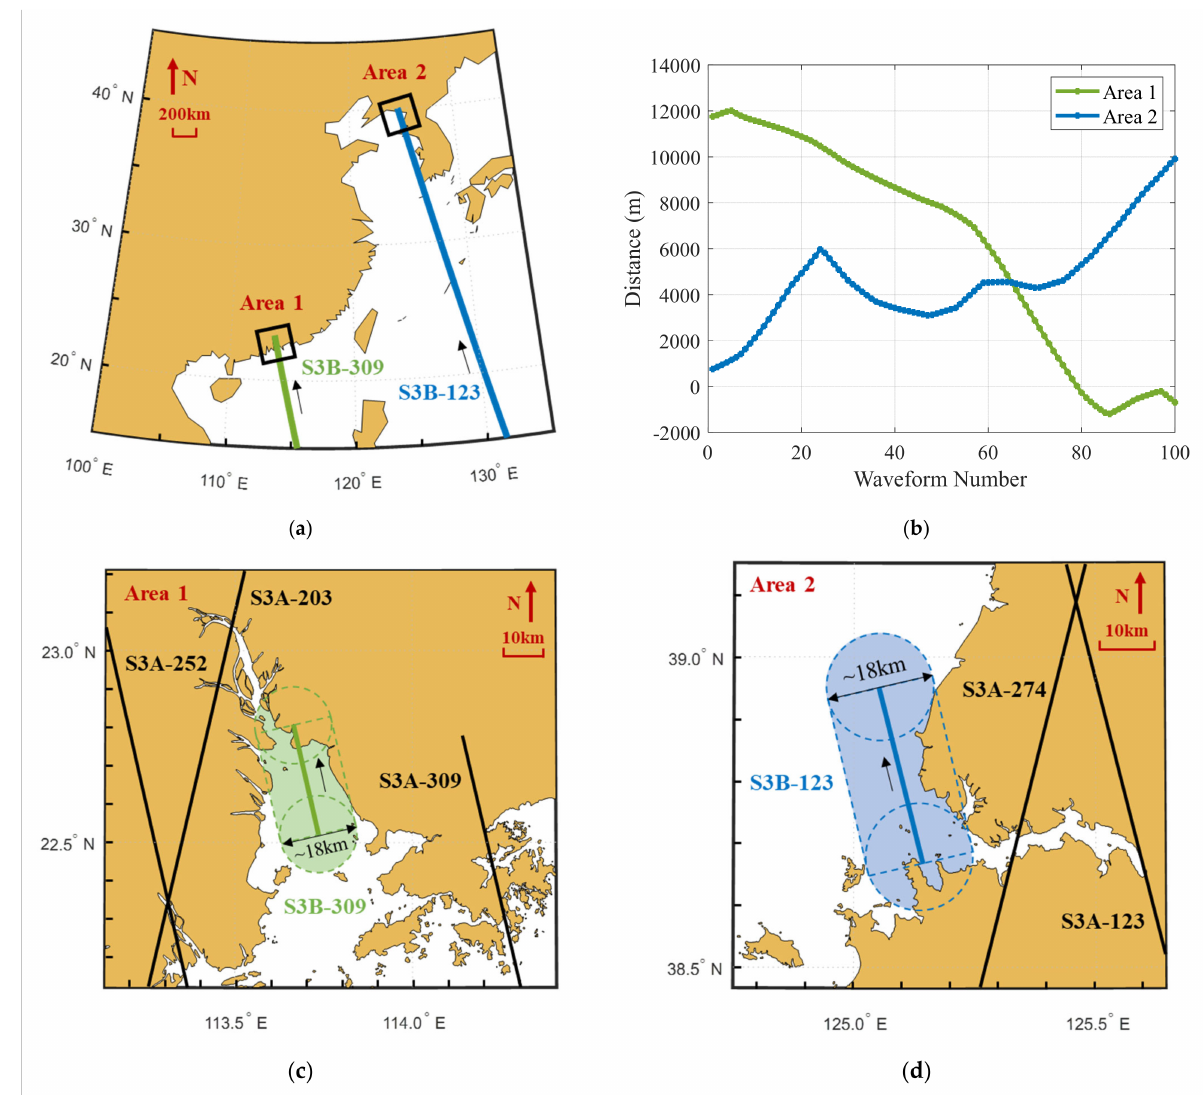
Figure 1. ( a ) The locations of the two experimental areas used for coastal waveform processing and the corresponding subsatellite tracks. ( b ) The offshore distances of the subsatellite points in the two experimental areas. ( c , d ) The coastal details of experimental areas 1 and